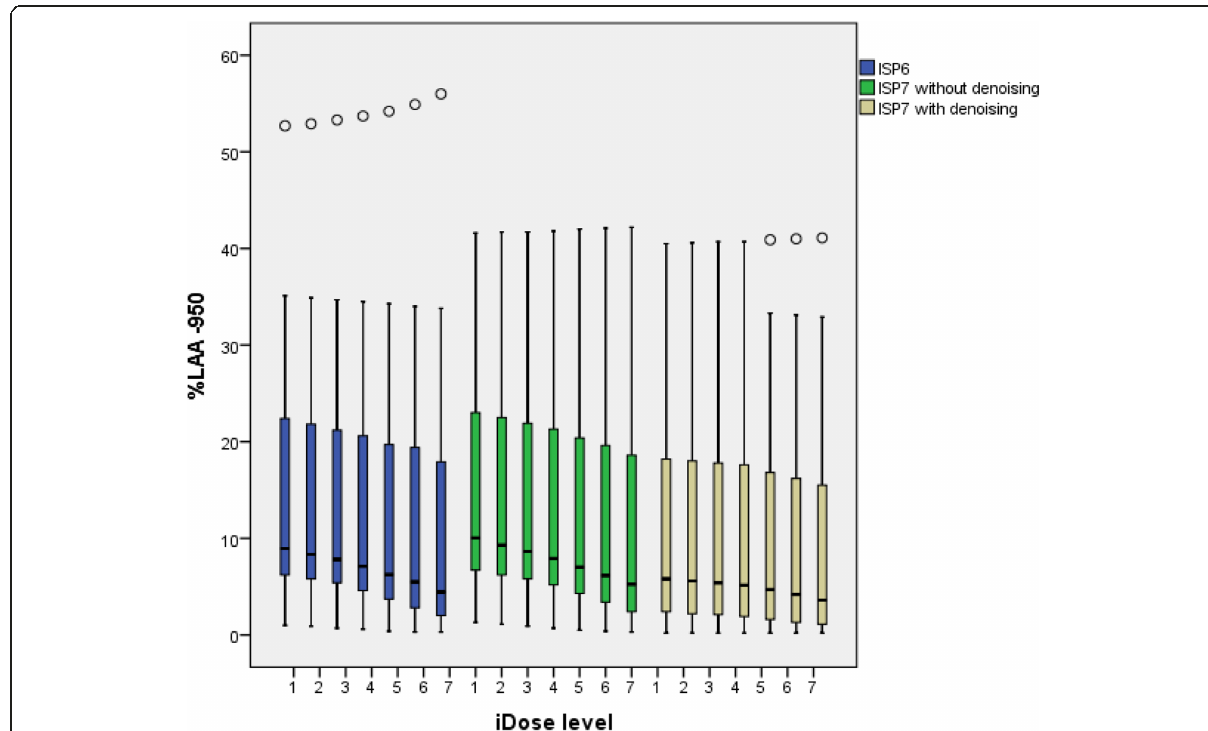
Fig. 4 Boxplot of %LAA-950 for the various iDose 4 levels of ISP6 and ISP7 with and without denoising ( n = 22, one patient had missing values). % LAA - 950 percentage of lung voxels with attenuation < − 950 Hounsfield units, ISP IntelliSpace